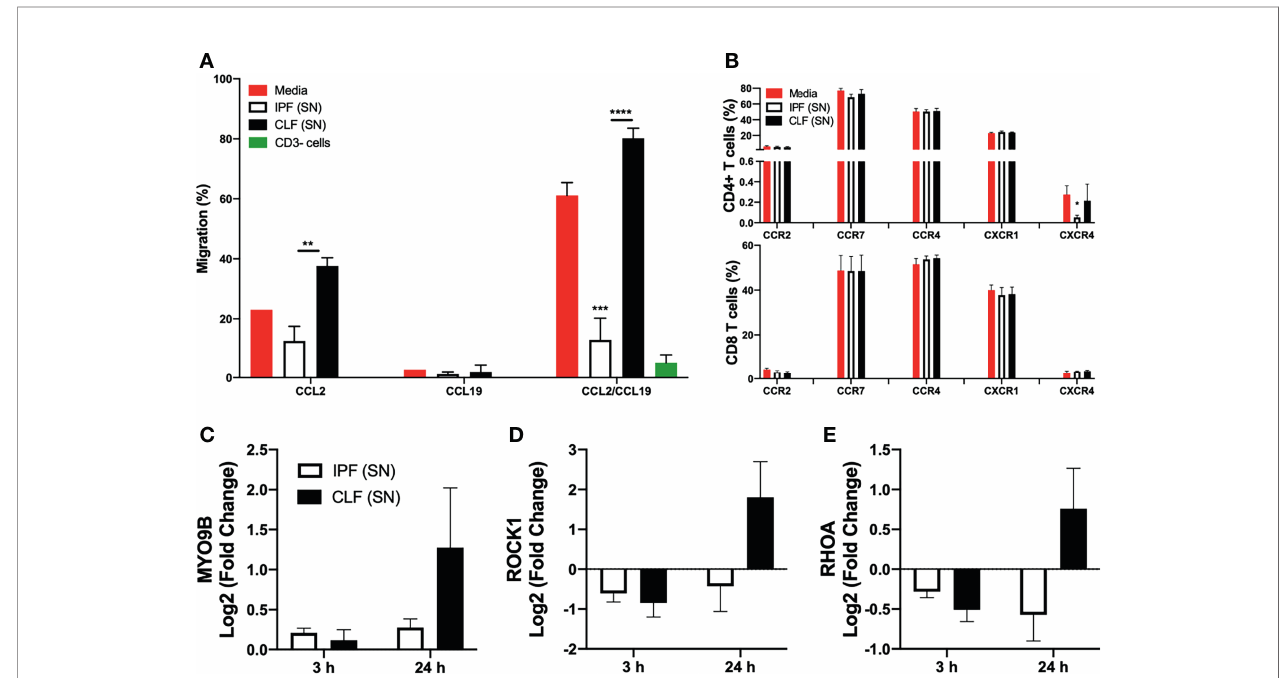
FIGURE 7 | The supernatant (SN) from IPF fi broblasts decreases the migration of T cells at long time of exposure. T cells from fi ve different healthy donors stimulated with different IPF (SN) and CLF (SN) were cultured during 24 h with IPF (SN) or control lung fi broblasts SN, and then cells were recovered to evaluate cell migration and expression of chemokine receptors by fl ow cytometry. T cells cultured during 3 and 24 h were used to evaluate MYO9B, ROCK1, and RHOA at the transcriptional level. (A) T cells were recovered at 24 h and their ability to migrate in response to CCL2, CCL19, and CCL-2/CCL19 was evaluated using a fl uorometric assay. The obtained relative fl uorescence unit is indicative of the magnitude of cellular migration, and the percentage is obtained normalizing the maximum level of T-cell migration (100%) in response to fetal bovine serum. The CD3 − cell fraction (green bar) was used as a negative control of migration to chemokines used. (B) Percentage of CD4+ T cells (up) and CD8+ T cells (down) positive to receptors CCR2, CCR7, CCR4, CXCR1, and CXCR4 obtained by fl ow cytometry. T cells cultured during 3 and 24 h were recovered, and we calculated the log2 fold change of MYO9B (C) , ROCK1 (D) , and RHOA (E) . Bars indicate mean ± SD from fi ve independent experiments. A multiple t -test and Holm – Sidak as post-test were used. * p < 0.05, ** p < 0.01, *** p < 0.001, **** p <